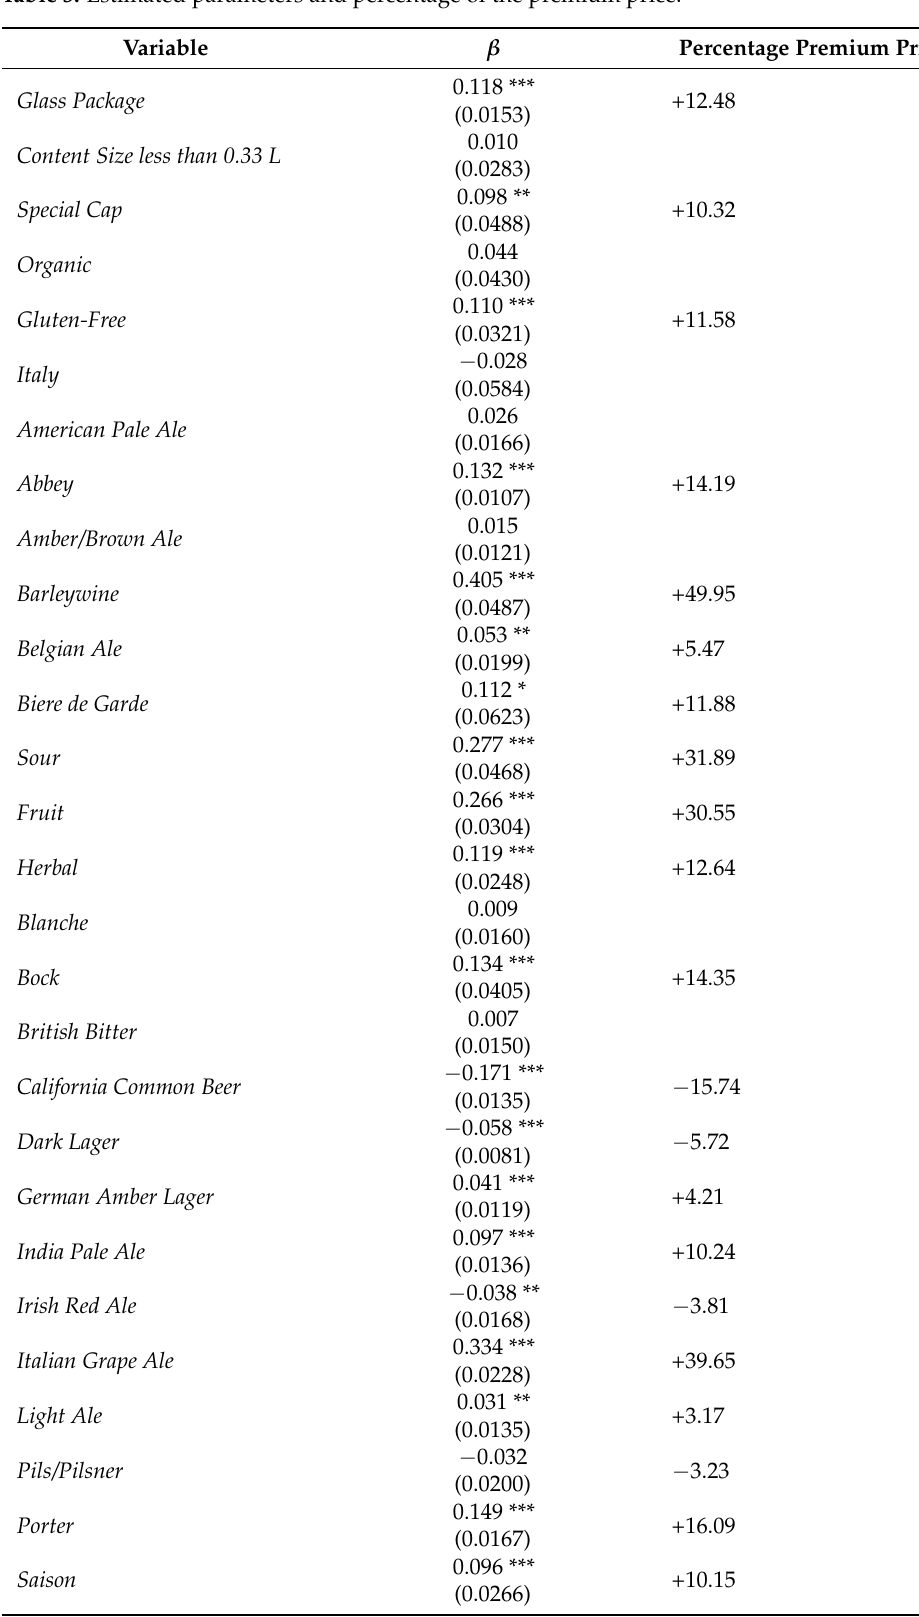
Table 3. Estimated parameters and percentage of the premium